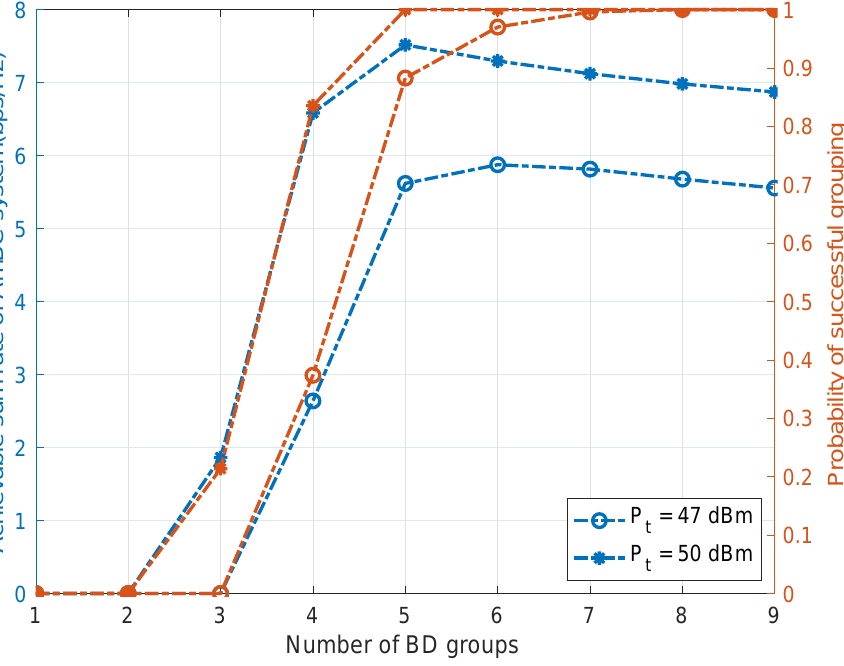
Figure 2. ASR vs. the number of BD groups.